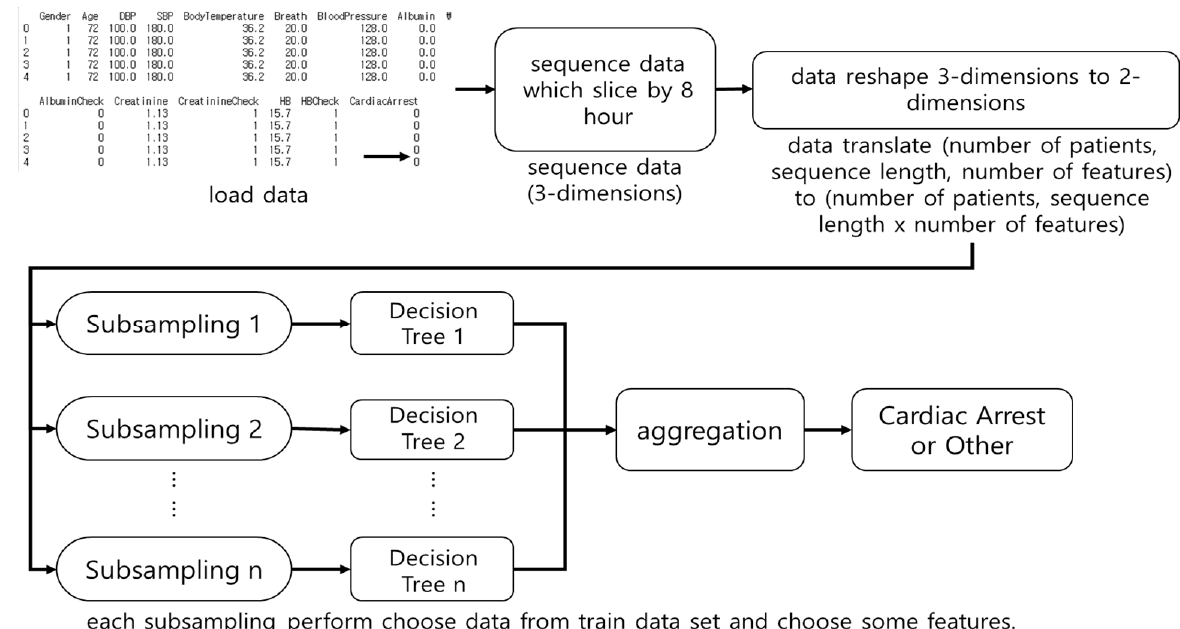
Figure 3. The architecture of Random Forest (RF). The RF was used as an input for multiple Decision Trees after subsampling the dataset and the results were aggregated.